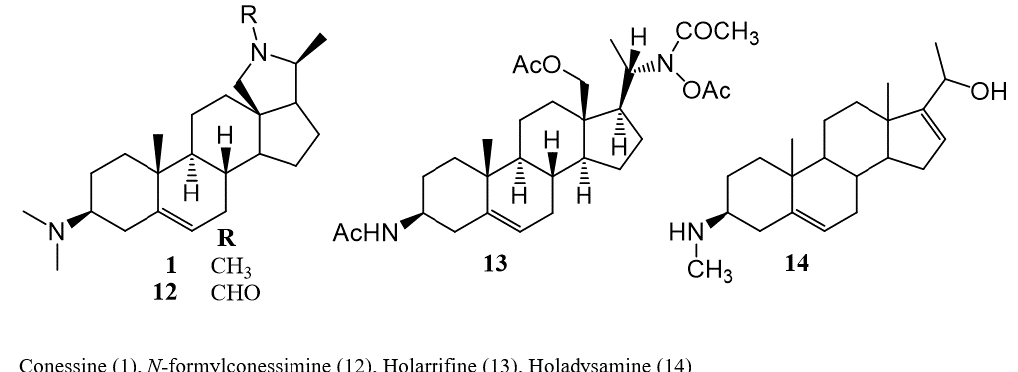
Figure 2 : Potent antibacterial alkaloids isolated from Genus